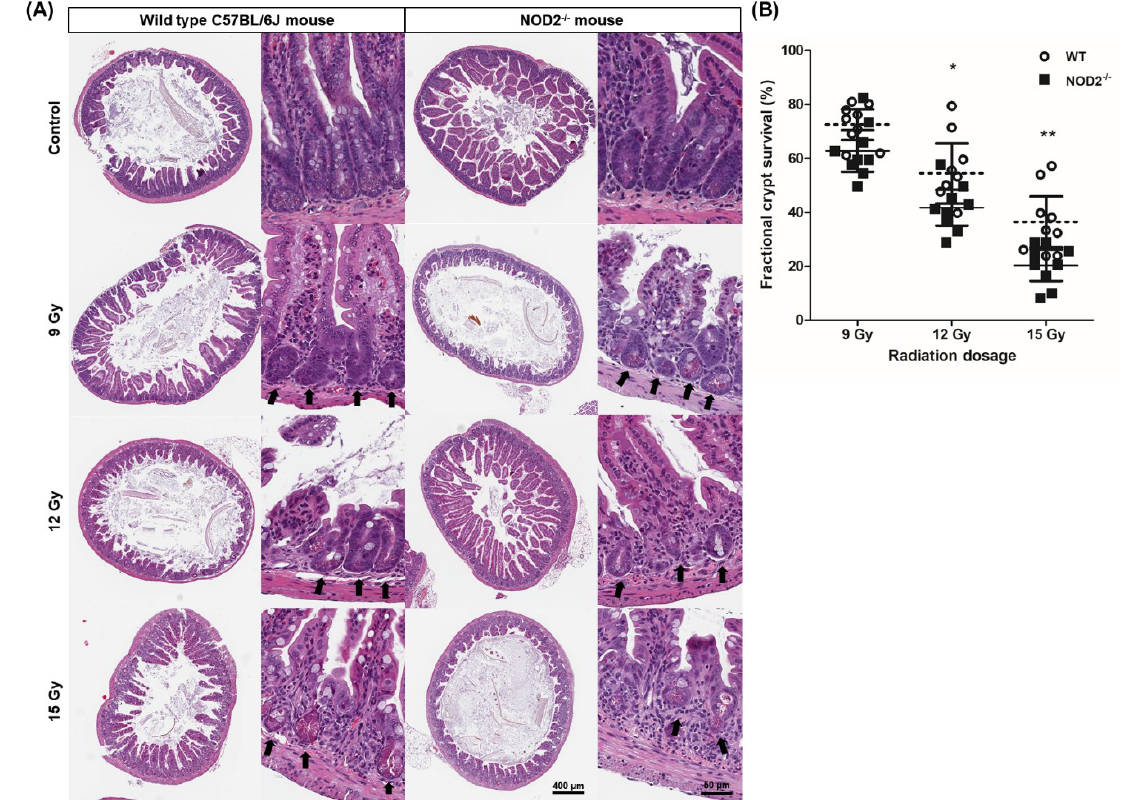
Figure 1. Dosage-dependent radiation damage of X-ray in the wild-type (WT) and NOD2 −/− mice. ( A ) Crypt microcolony assay. Arrows indicated the regenerative crypts. ( B ) Fractional crypt survival rate according to different doses of irradiation. Differences were evaluated by two-way ANOVA followed by Bonferroni post-test; * p < 0.05, and ** p < 0.01.